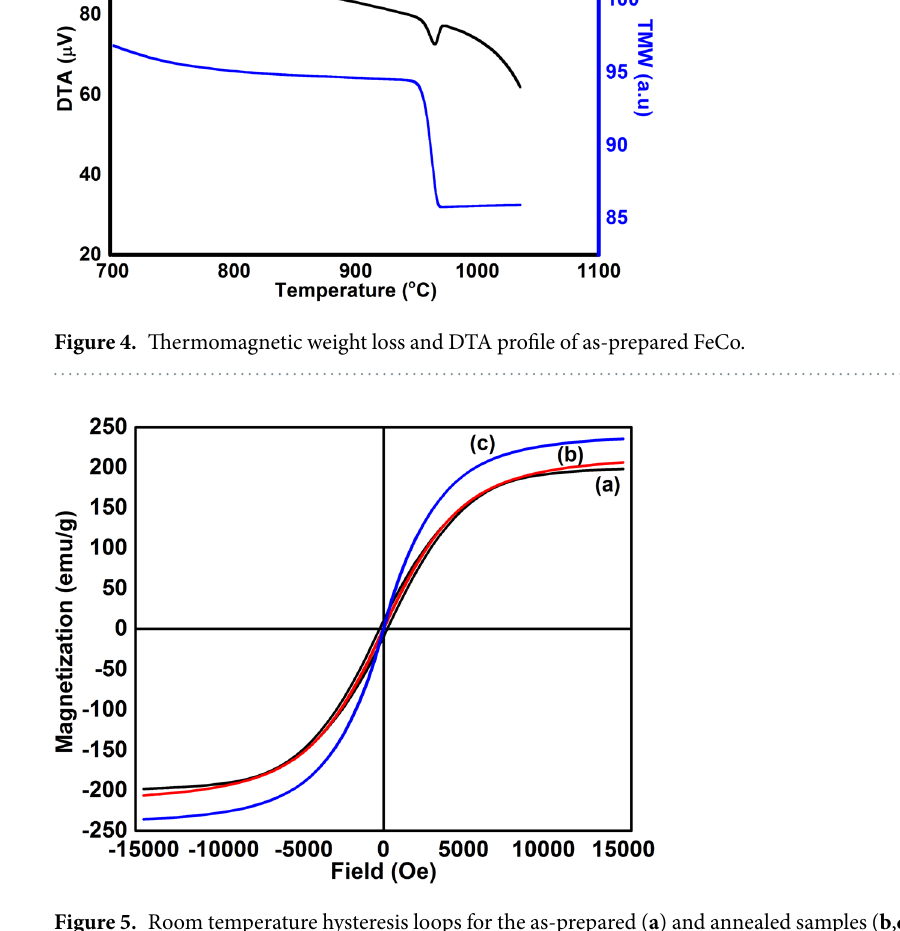
Figure 5. Room temperature hysteresis loops for the as-prepared ( a ) and annealed samples ( b , c ).